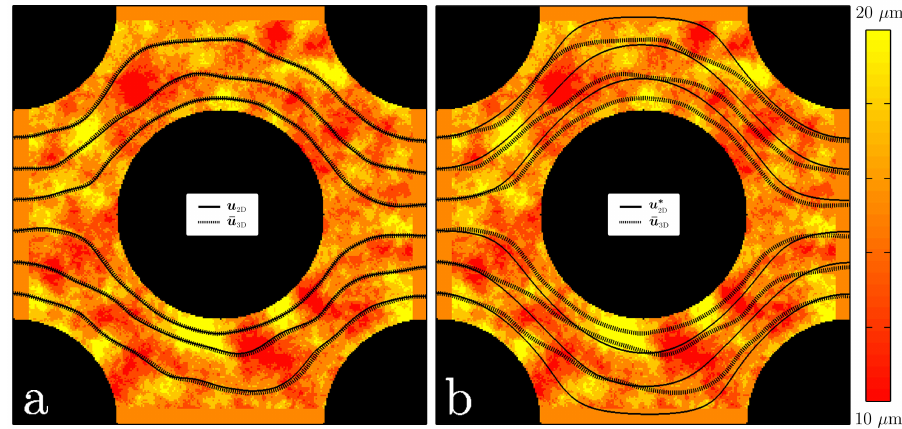
Figure 4. Streamlines in a unit cell with spatially-correlated random aperture between 10 and 20 µ m, with aperture covariance range of θ ≈ 0 . 1 (as a fraction of the unit cell length). ( x, y ) and ¯ u ( x, y ) are shown in ( a ), while streamlines for u ∗ Streamlines for u 2D 3D ¯ u ( x, y ) are shown in ( b 3D